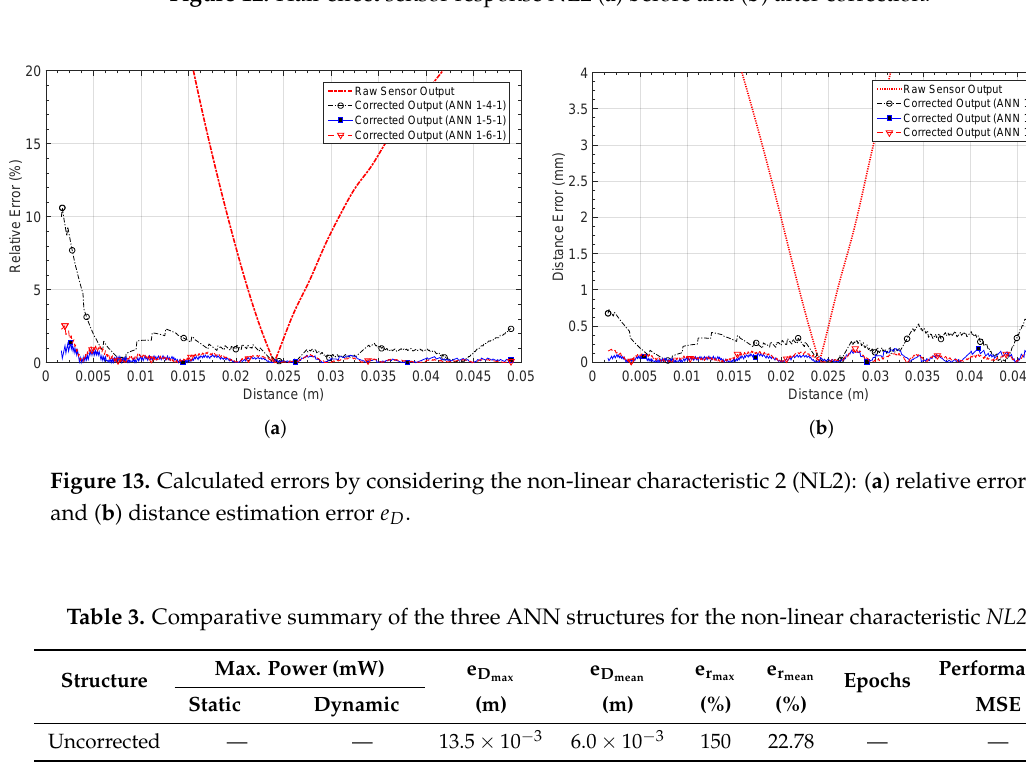
e D → Error in the estimation of distance. e r → Relative